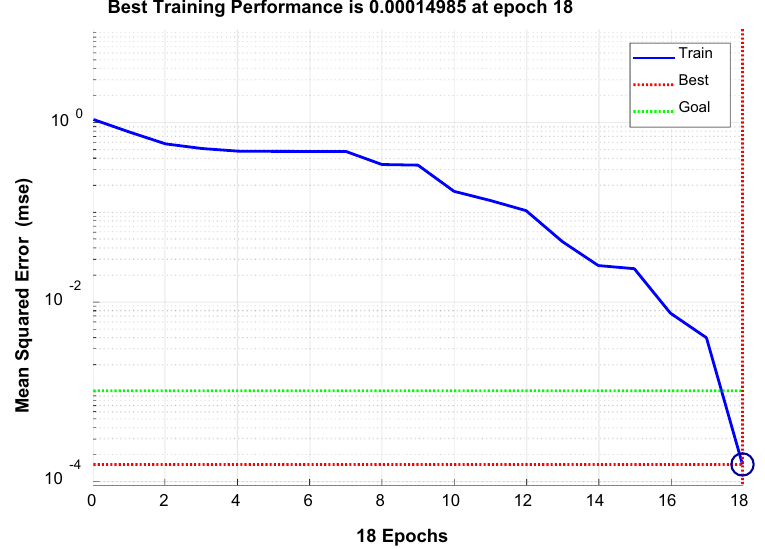
Figure 16. Trainlm performance curve.